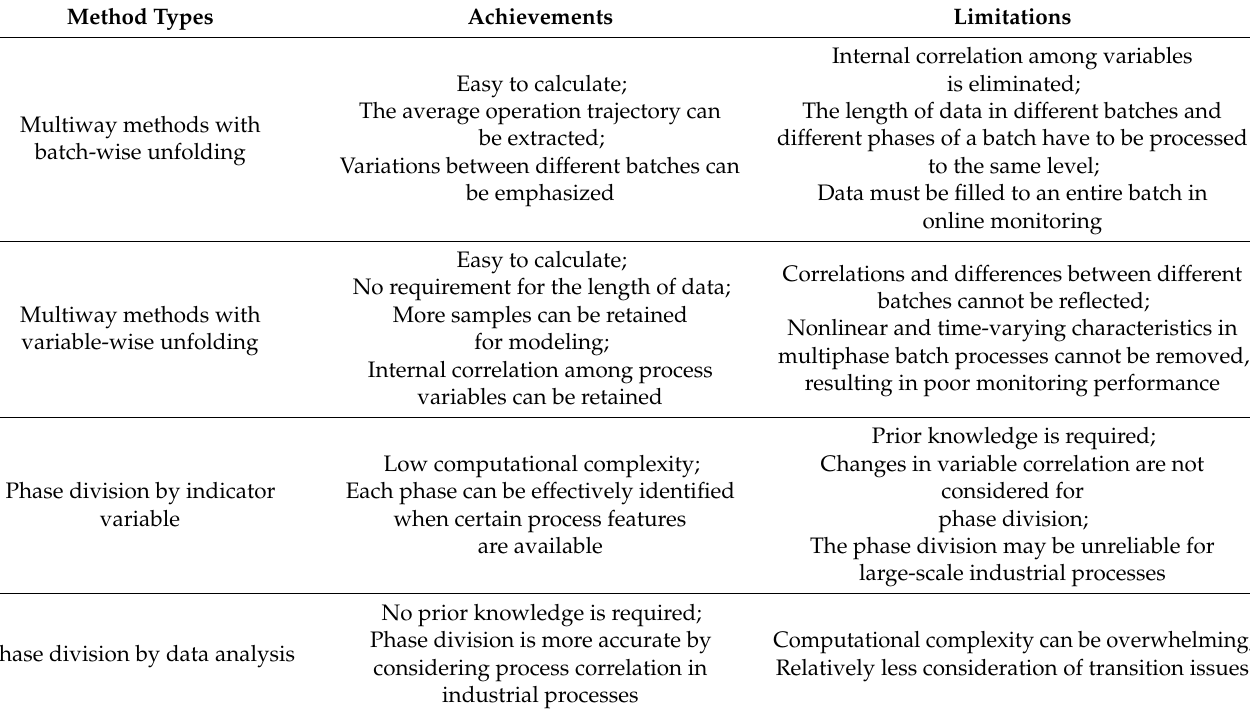
Table 8. Comparative analysis of batch processing